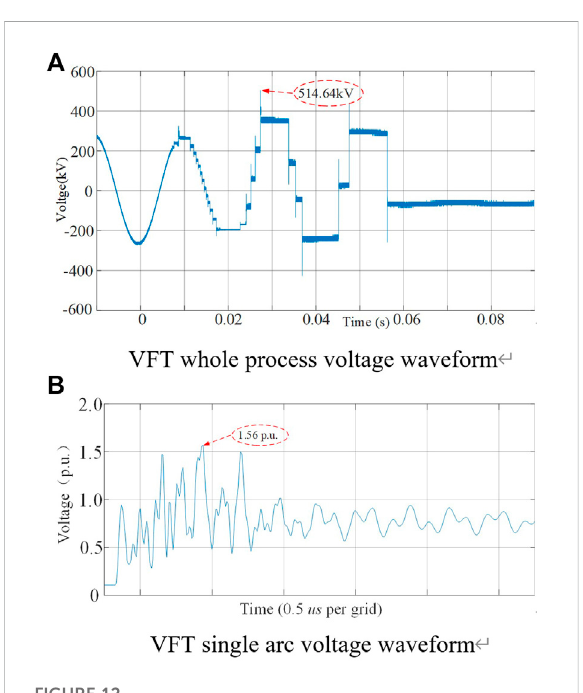
FIGURE 12 MeasuredVFTwaveformgeneratedbydisconnectoropening and closing no-load line. (A) VFT whole process voltage waveform. (B) VFT single-arc voltage